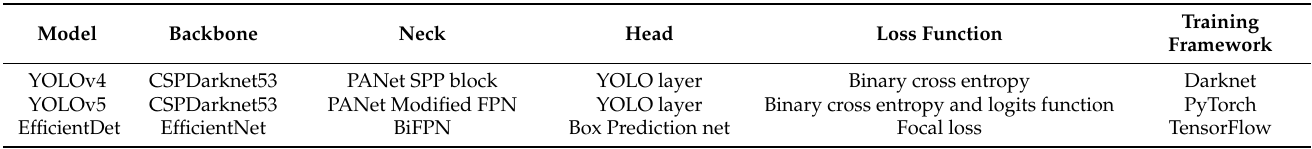
Table 1. YOLOv4, YOLOv5, and EfficientDet deep learning object detection algorithms basic architec- ture